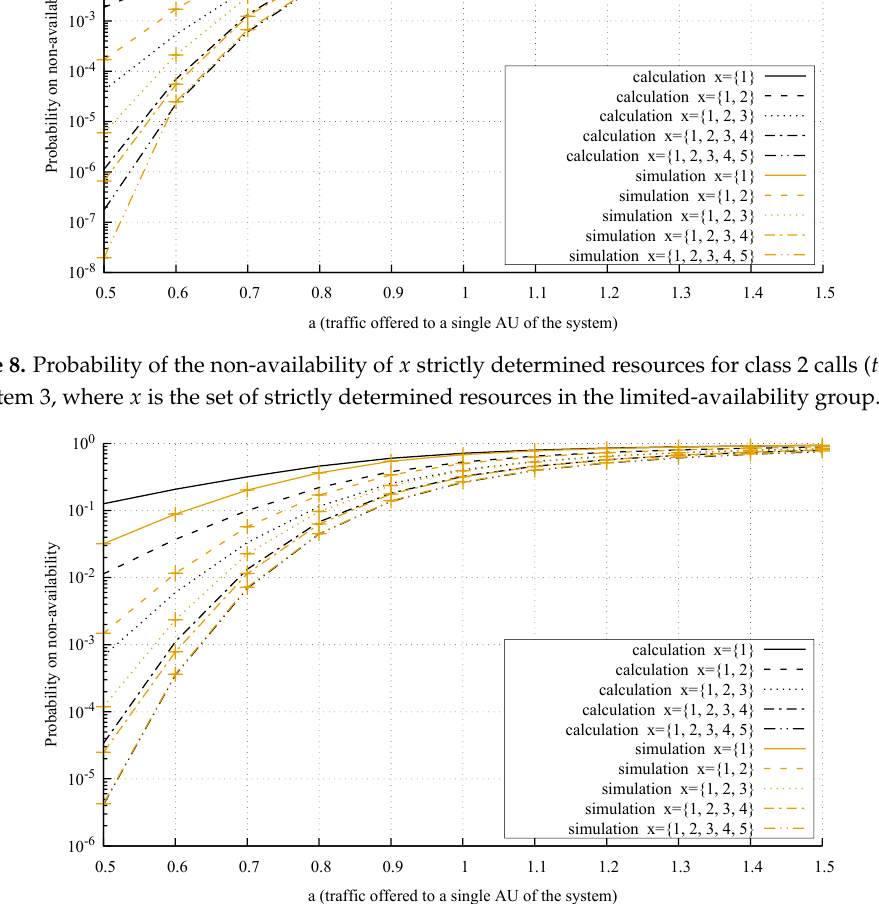
Figure 9. Probability of the non-availability of x strictly determined resources for class 3 calls ( t 3 = 7) in System 3, where x is the set of strictly determined resources in the limited-availability